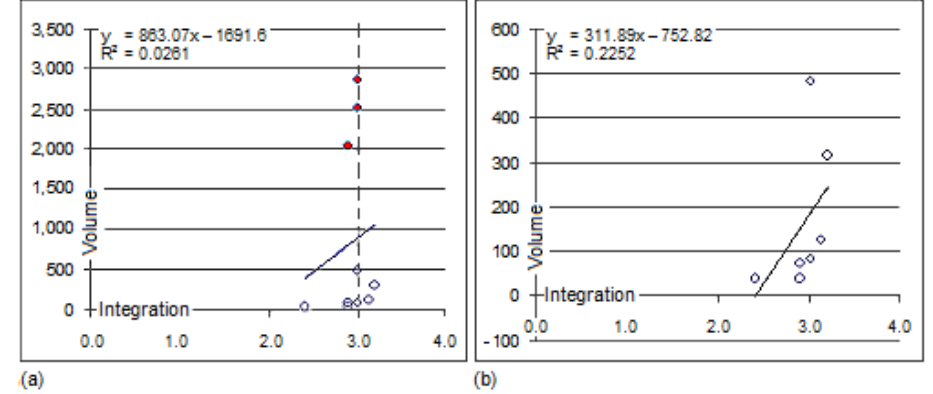
Figure 6. Scatterplots: axial analysis. (a) All-roads. (b) Residential-streets. Noticeably, the scatter of the all-roads category develops a paradox. Imagine a line [refer to Figure 6(a)] that distinguishes the relative positions of the solid dots amongst all hollow ones in terms of their integration measures. The line here clearly identifies that quite a few hollow dots have received higher integrations than the solid ones. Syntactically, this implies the fact that some of the residential streets of the neighborhood are expected to receive more trips than the arteries. In reality, however, the traffic counts of the arteries are found to be much higher averaging almost 2,500 vph than those of the residential streets averaging nearly 200 vph (see Table 1). This contradictory relationship between the two outliers substantially weakens the overall integration-movement relationship of the axial analysis of Tech